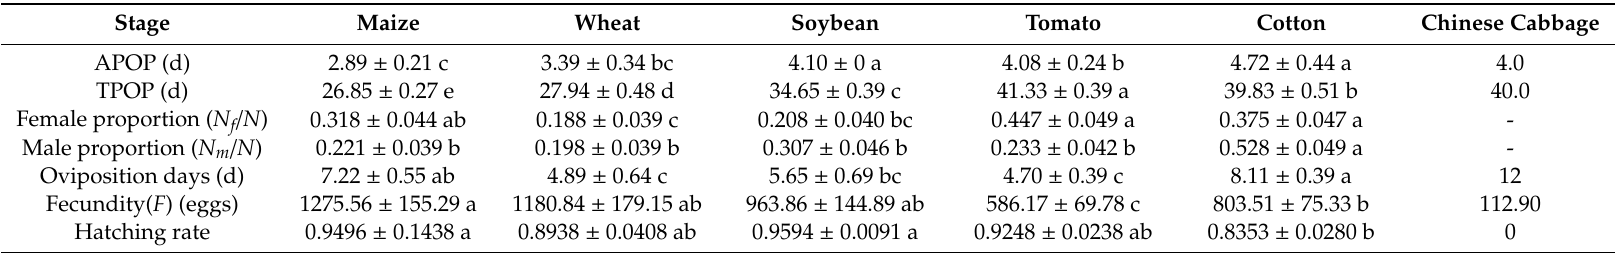
Table 2. APOP, TPOP, female and male proportions, mean fecundity and egg hatching rate (M ± SE) of S. frugiperda fed on six plant